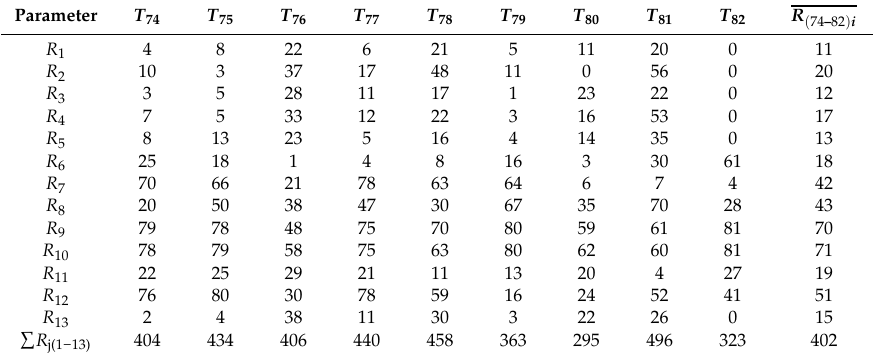
Table A24. Ranking of T j territories on land activity, Far Eastern Federal